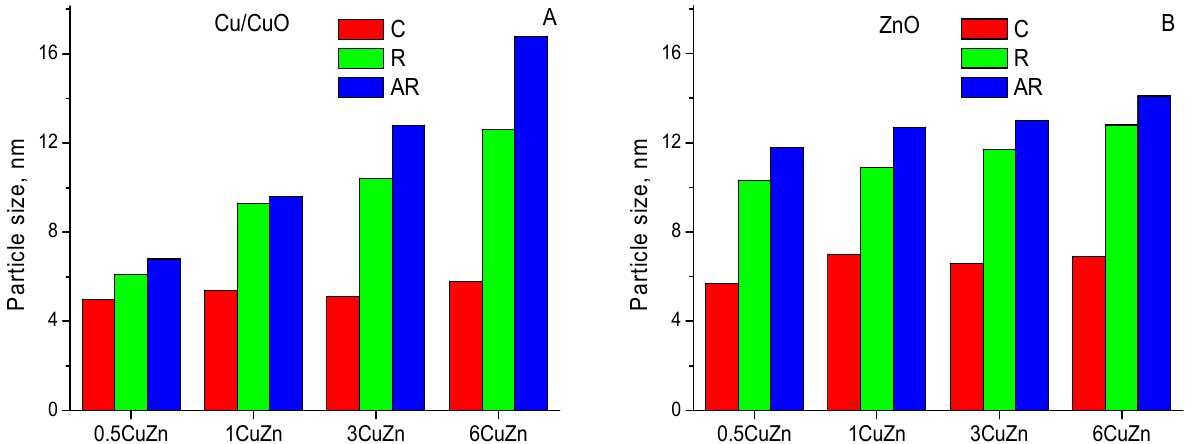
Figure 2. The crystallite size of CuO or Cu ( A ) and ZnO ( B ) determined from XRD patterns of calcined mixed oxides (C), reduced samples (R) and spent catalysts (AR).